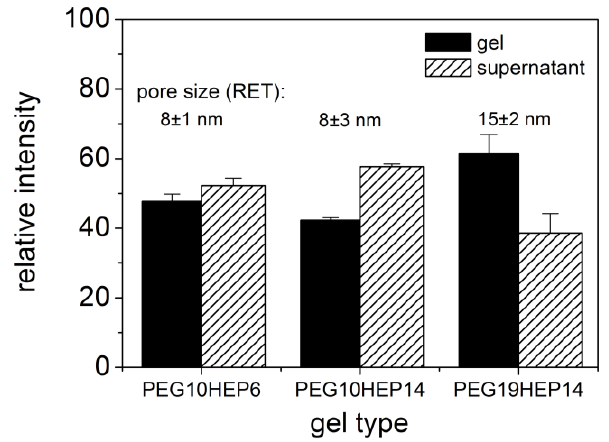
Figure 5. Average fluorescence intensity of TRITC-labeled BSA after 24 h in supernatant (solution) and in the starPEG-heparin hydrogel body. Shown are mean values ± SD for different gel types with a starPEG to heparin ratio of 3 (n = 2, mean values represent average intensity over 3 z-lines in gel or supernatant). Measurements were performed by using cLSM. Comparison with the pore sizes determined from the storage moduli by using